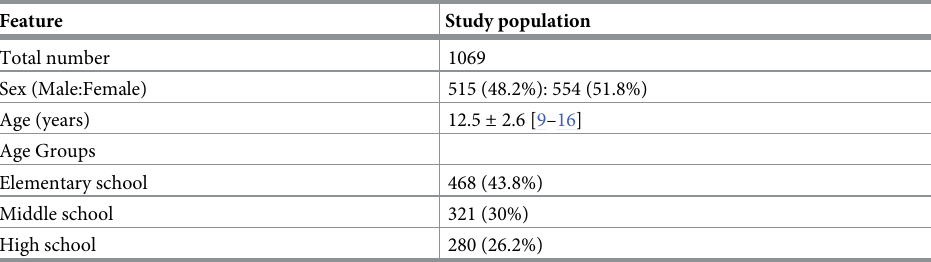
Table 1. Characteristics and demographics of children in this